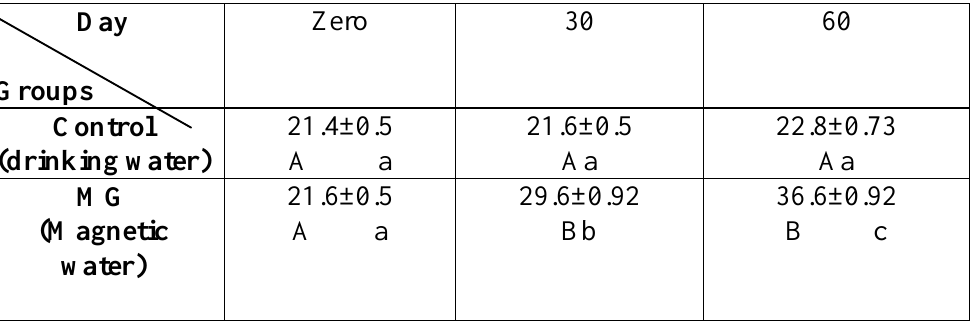
Table (2): Effect of exposure to magnetized water for 60 days on serum glutathione concentration (µmol/l) of adult male rabbits